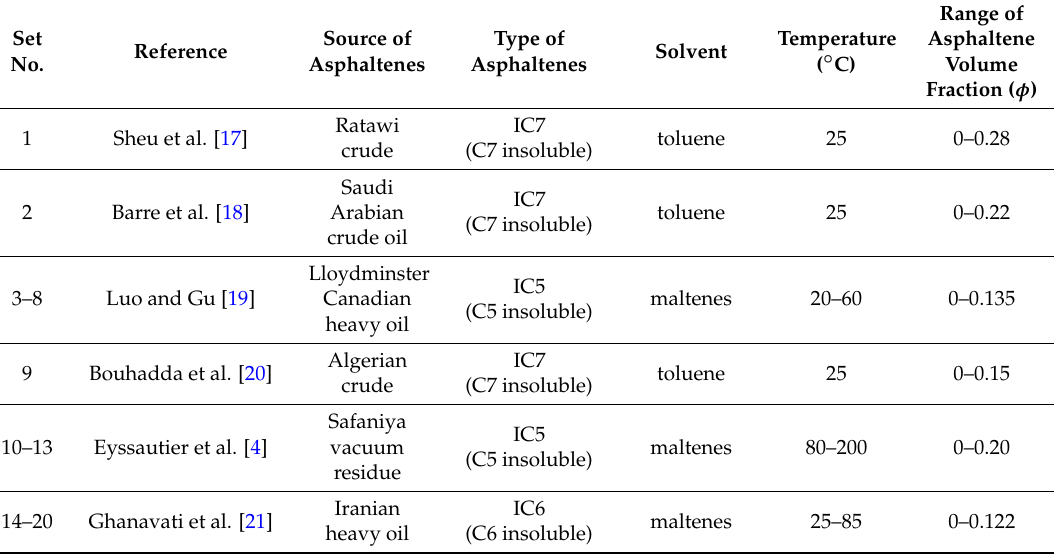
Figure 9. Twenty sets of experimental relative viscosity data gathered from different sources in the literature. Table 1. Twenty sets of viscosity data on asphaltene suspensions taken from different